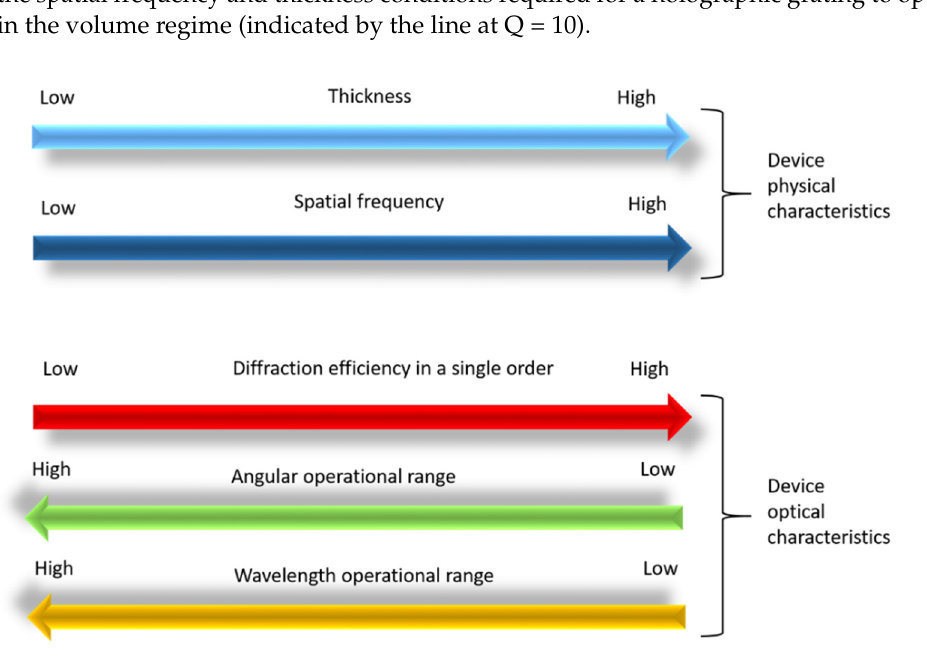
Figure 1. Relationship between the physical and optical characteristics of the hologram and their relevance to the design of the HOE.